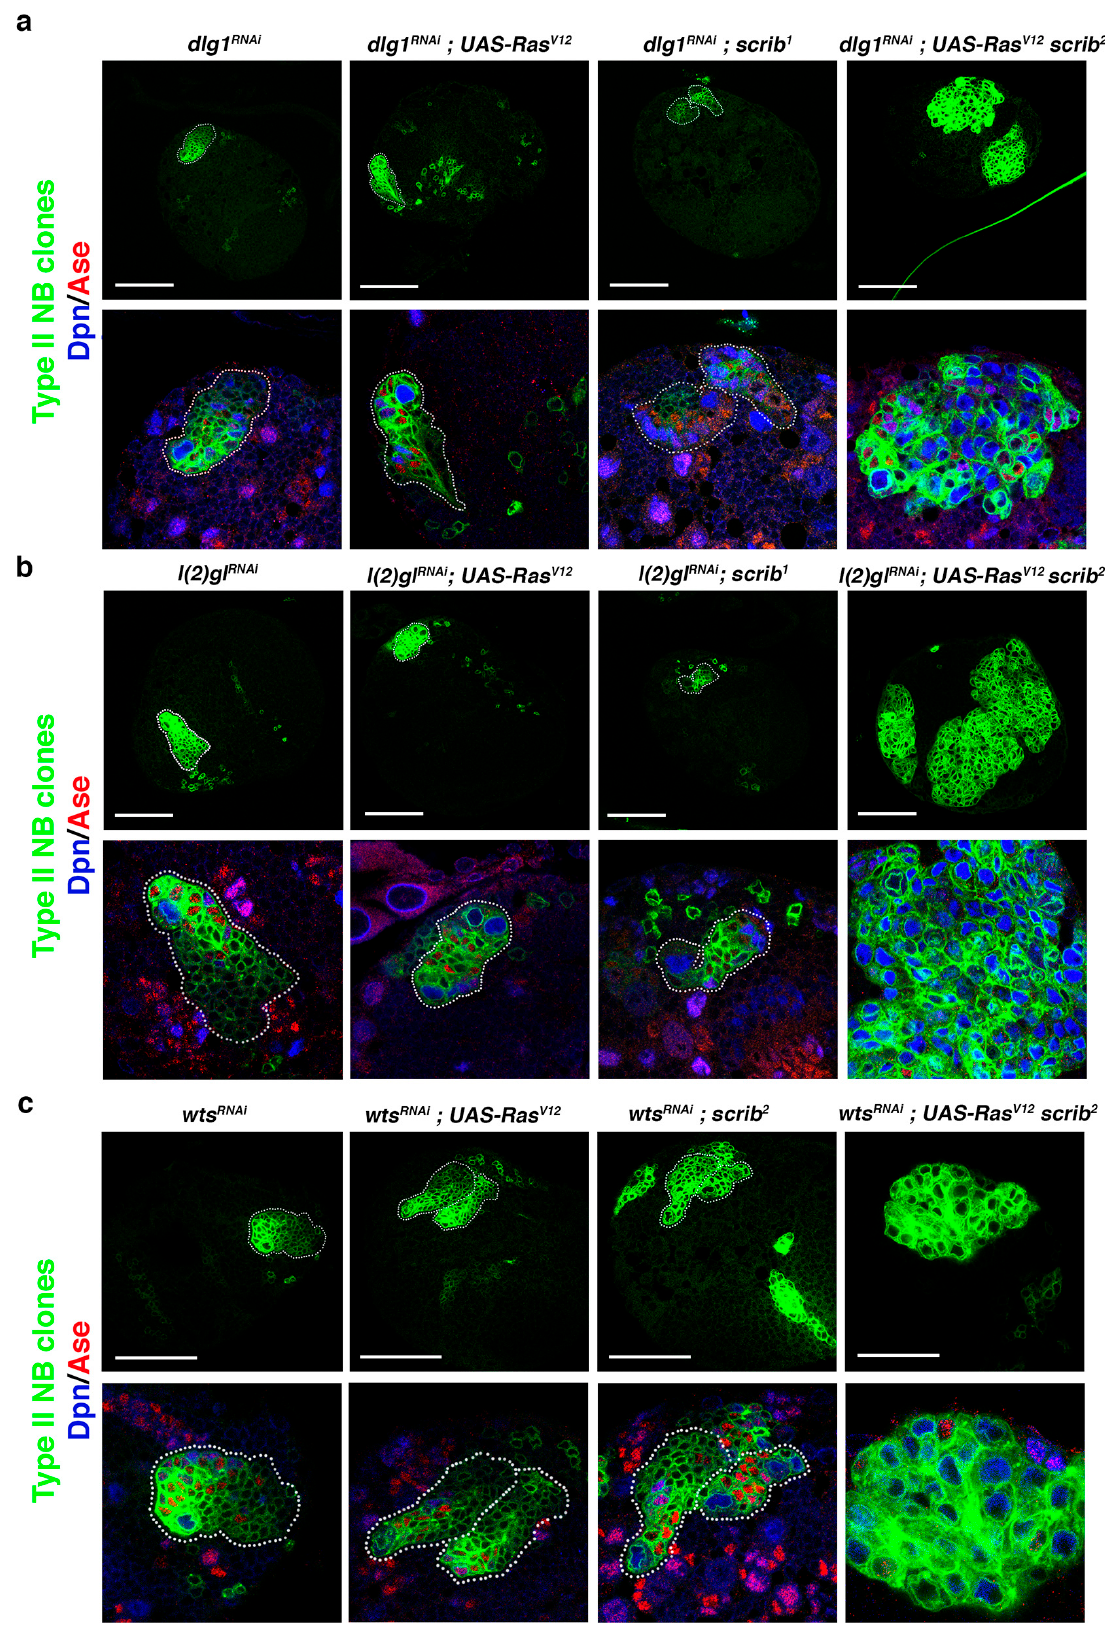
Figure 2. Downregulation of known ACD regulators in Ras V 12 scrib NBII mutant clones induces tumor-like overgrowth. ( a ) Confocal micrographs showing brain hemispheres with NBII lineages of the indicated genotypes. Below each hemi- sphere, detailed views of the corresponding NBII lineage stained with Dpn (blue) and Ase (red) are displayed at the same